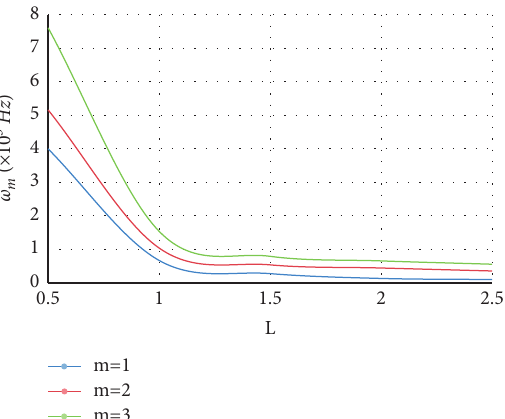
Figure 5: Relation between frequency and length of five-layered shells 0 0 /90 0 /0 0 /90 0 /0 0 ( EGE / KE / EGE / KE / EGE ) ; n � 2.